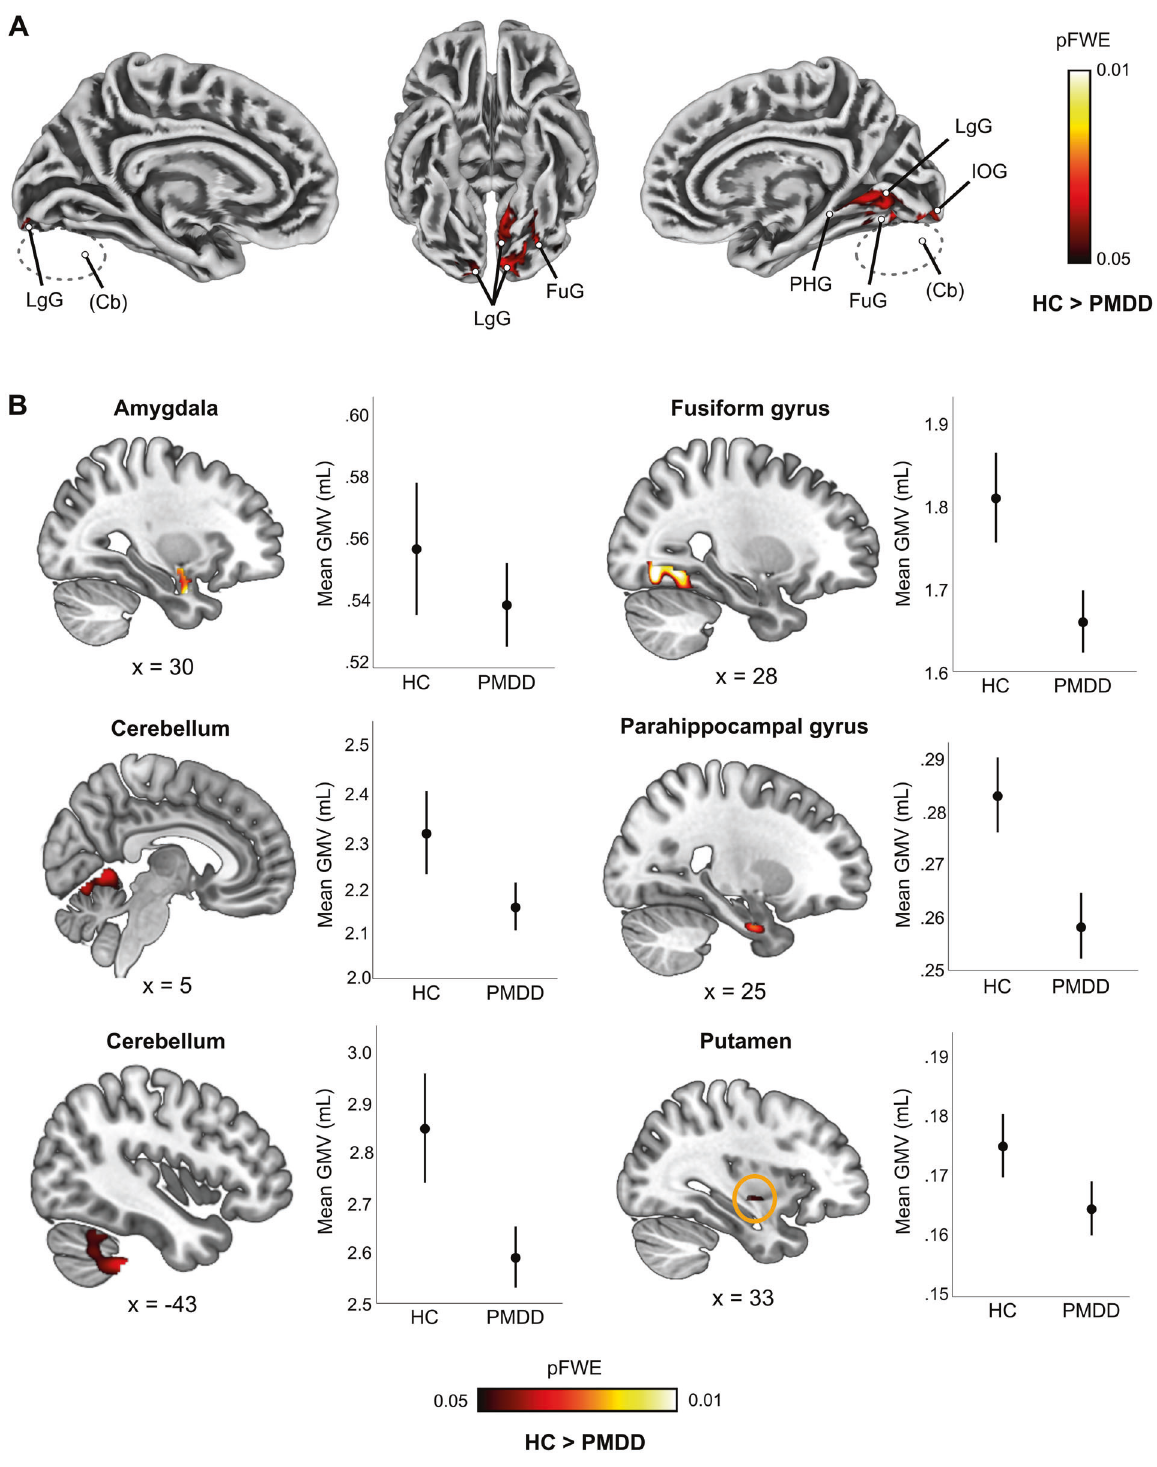
Fig. 1 Group difference in grey matter volume between women with premenstrual dysphoric disorder and healthy controls ( p FWE < 0.05, TFCE). A Surface representation of the signi fi cant clusters showing lower grey matter volume in women with PMDD compared to healthy controls across the whole brain. B Sagittal slice overlays and plots illustrating lower grey matter volume in women with PMDD compared to healthy controls within ROIs (TFCE, p < 0.05, FWE-corrected). Localization of the brain slices along the x axis is given by the Montreal Neurological Institute coordinates below each slice. The plots illustrate the average raw grey matter volume within the signi fi cant clusters resulting from the voxel-wise ROI analyses, in the PMDD and the control groups. The error bars represent 95% con fi dence interval. No signi fi cant group difference in the opposite direction was found. Cb cerebellum, FuG fusiform gyrus, FWE Family Wise Error correction, GMV grey matter volume, IOG inferior occipital gyrus, LgG lingua gyrus, PHG parahippocampal gyrus, TFCE Threshold Free Cluster Enhancement, PMDD premenstrual dysphoric disorder, HC healthy